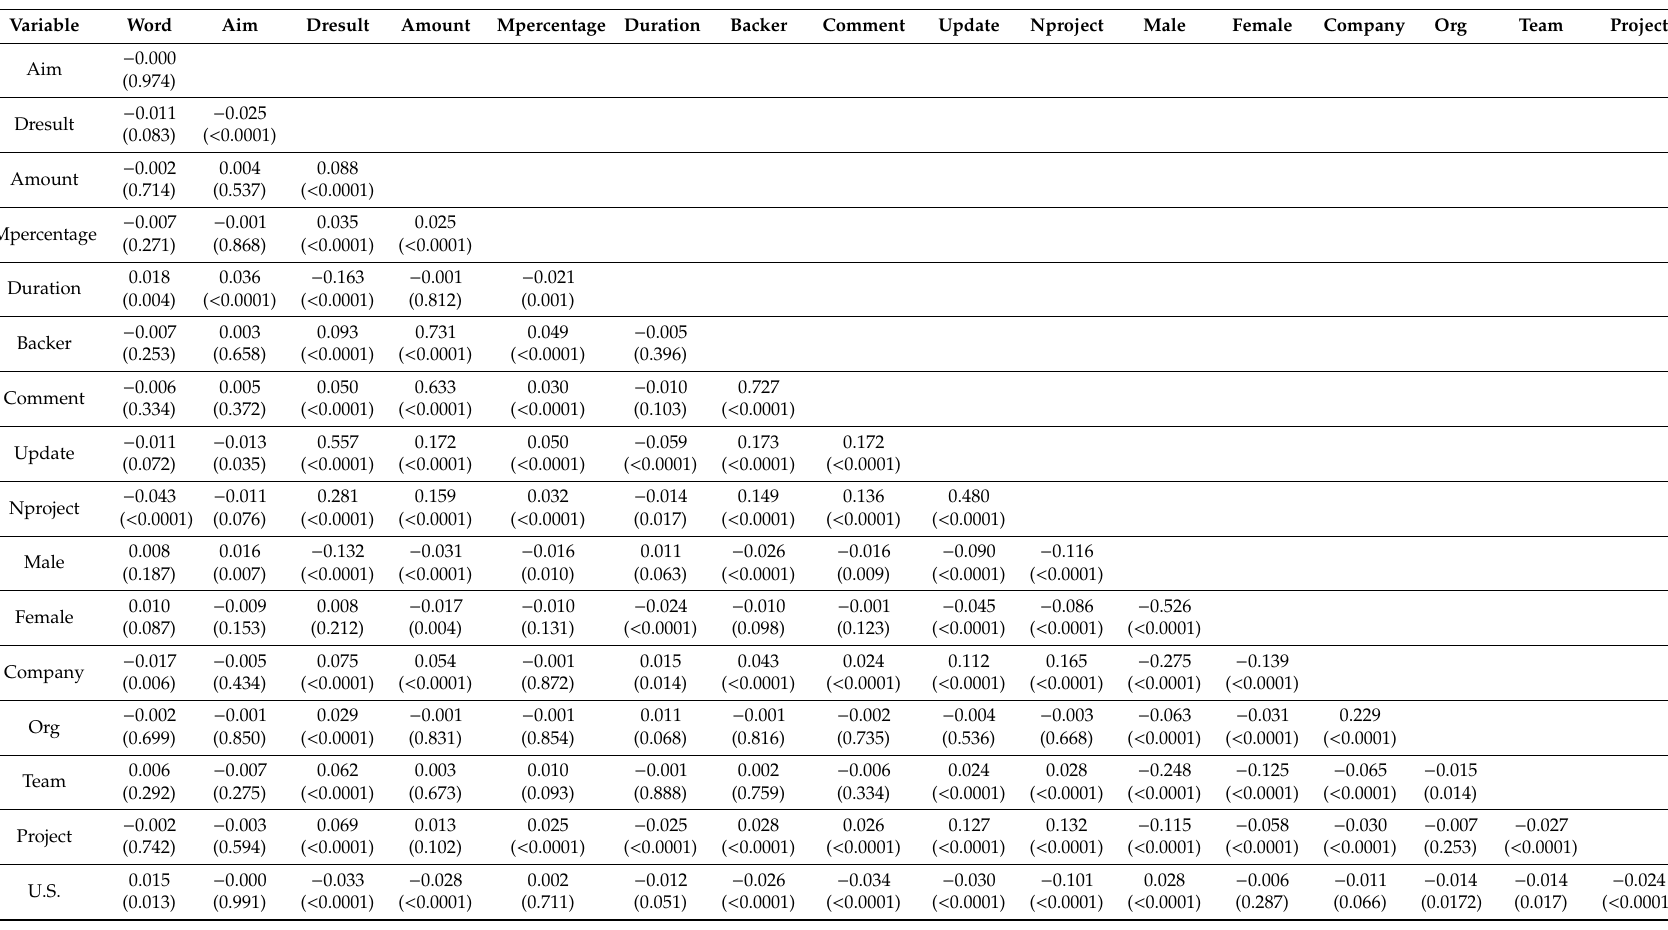
Table 6. Correlation matrix. This table reports the correlation coe ffi cient and its significance level for each variable used in this study. Table 3 defines all the variables.